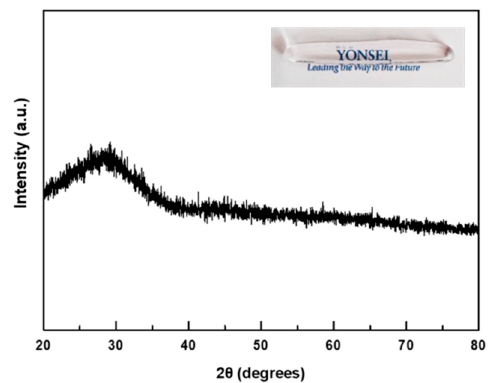
Figure 1. XRD patterns of the Zn-PBG powder (before mixing with flowable composite resin). The absence of crystallization peaks was confirmed on the sample, indicating the characteristic of the amorphous glass structure.